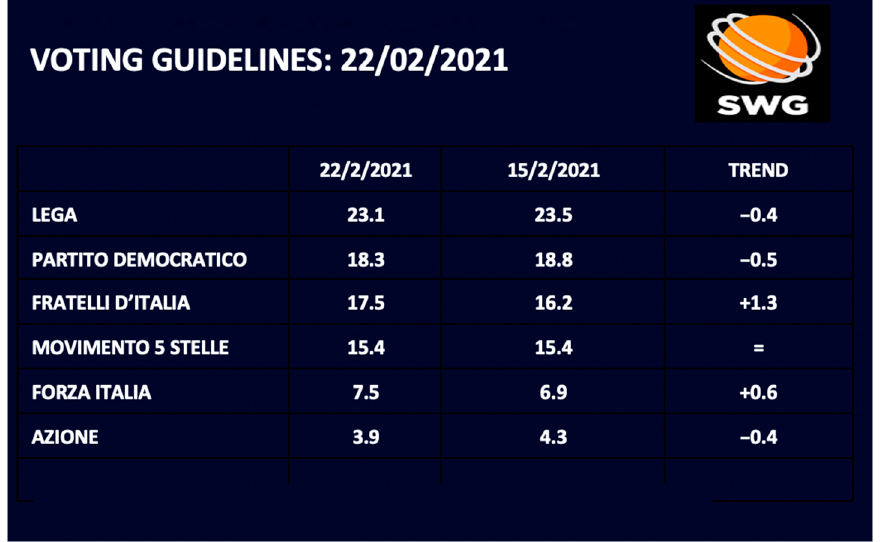
Figure 5. Polls retrieved by Swg, February 2021.